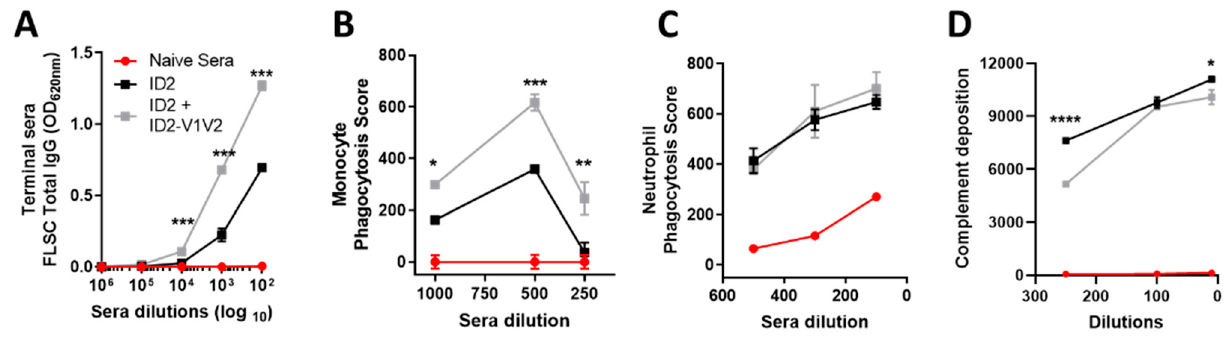
Figure 6. Fc-effector functions against a full-length single chain. ( A ) Full-length single chain (FLSC)-specific IgG induced in the sera of ID2 and ID2+ID2-V1V2 immunized mice. ( B ) Antibody-dependent cellular phagocytosis (ADCP) by THP-1 effectors and ( C ) antibody-dependent neutrophil phagocytosis (ADNP) of the FLSC-coated beads incubated with immunized sera, using two separate neutrophil donors. ( D ) Antibody-dependent complement deposition (ADCD). All analysis was carried out in triplicate, displaying the mean ± SEM. Statistical analysis is via two-way ANOVA with Sidak multiple comparison correction to detect differences between ID2 and ID2-V1V2 samples; * p < 0.05, ** p < 0.01, *** p < 0.001, **** p < 0.0001.